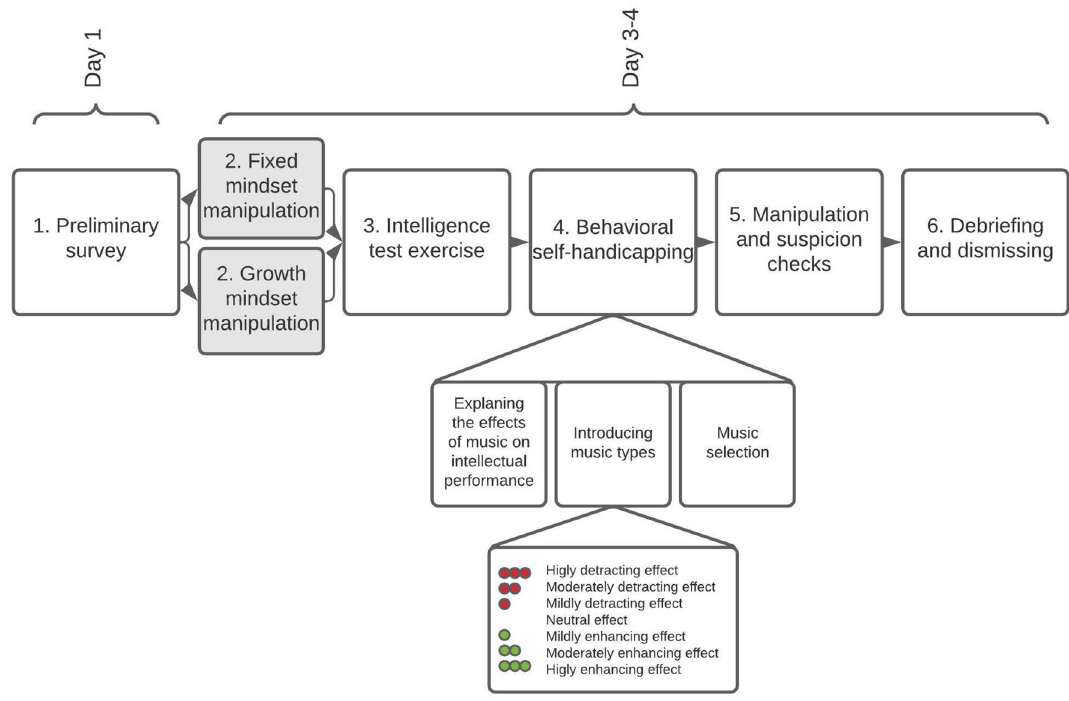
Figure 1. The procedure of the experiment. Participants were invited to participate in a laboratory study— allegedly—in order to validate a test to measure intellectual skills among Hungarian university students. First, participants filled out a preliminary online questionnaire set (e.g., demographic data, personal importance of intelligence, implicit intelligence theory) prior to the laboratory experiment. A few days later, upon arrival to the laboratory they were randomly assigned to one of the two experimental conditions (fixed/growth intelligence mindset). Then they were provided two solvable and four unsolvable “trial” intelligence test